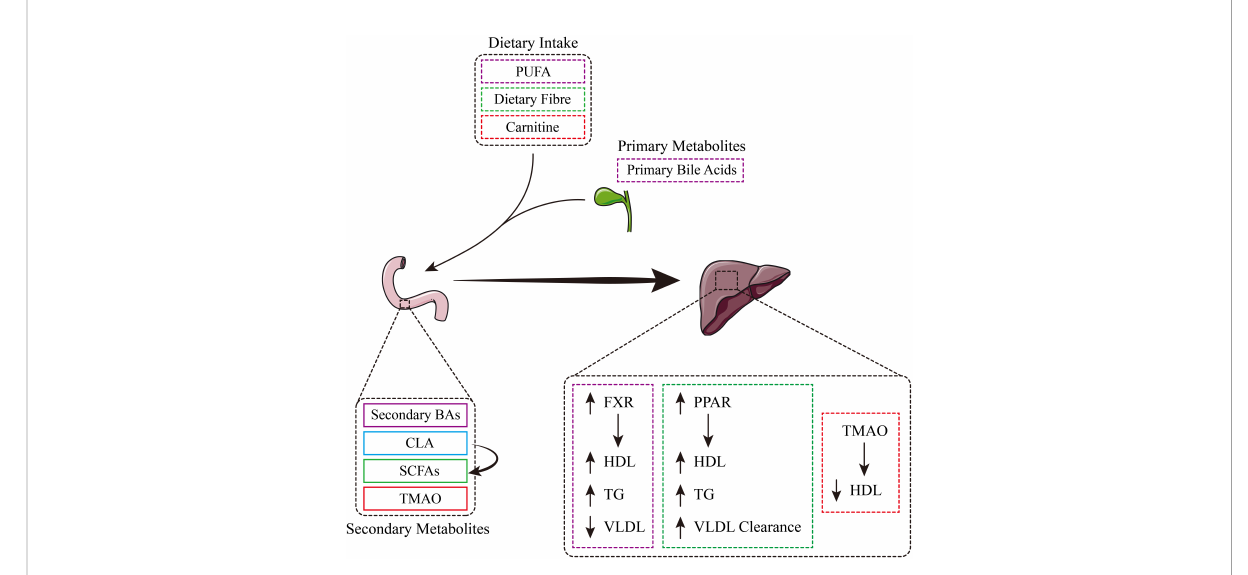
FIGURE 2 Schematic diagram of the interaction between diet, gut microbiota and lipid metabolism.